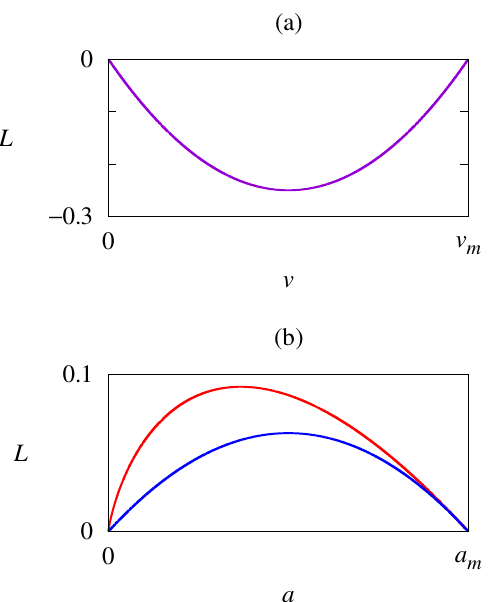
Figure 1. ( a ) Dependence of the Lagrangian L on ( a ) the speed v (in the absence of acceleration, a = 0 ). ( b ) Dependence of L on a (for v = 0 ) for the quadratic form (blue) and the logarithmic form